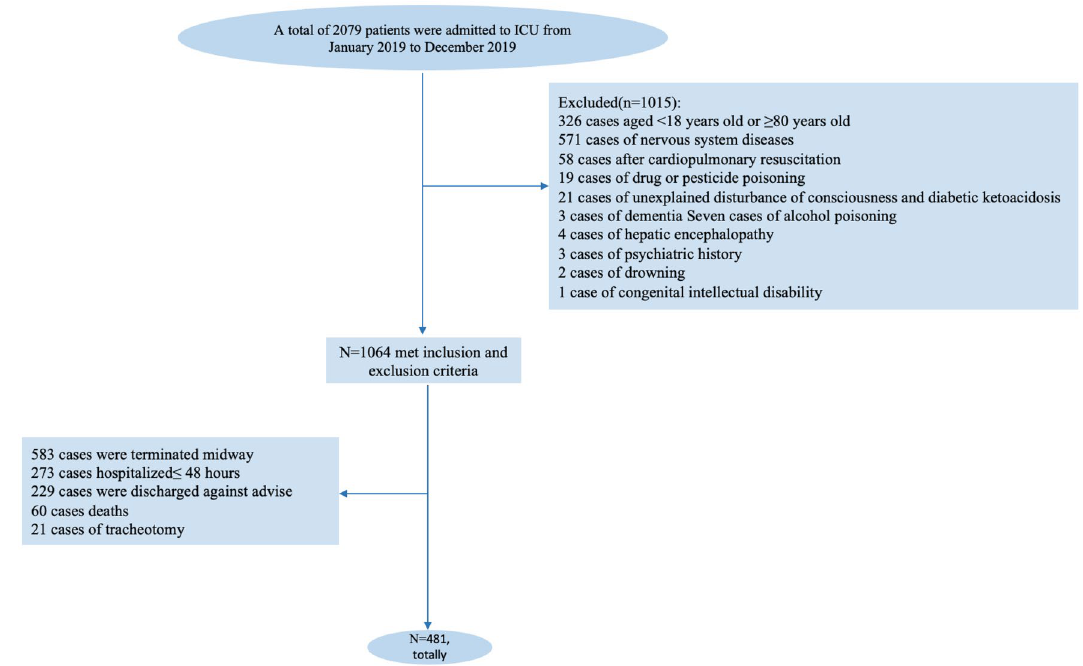
Figure 2. Flowchart of